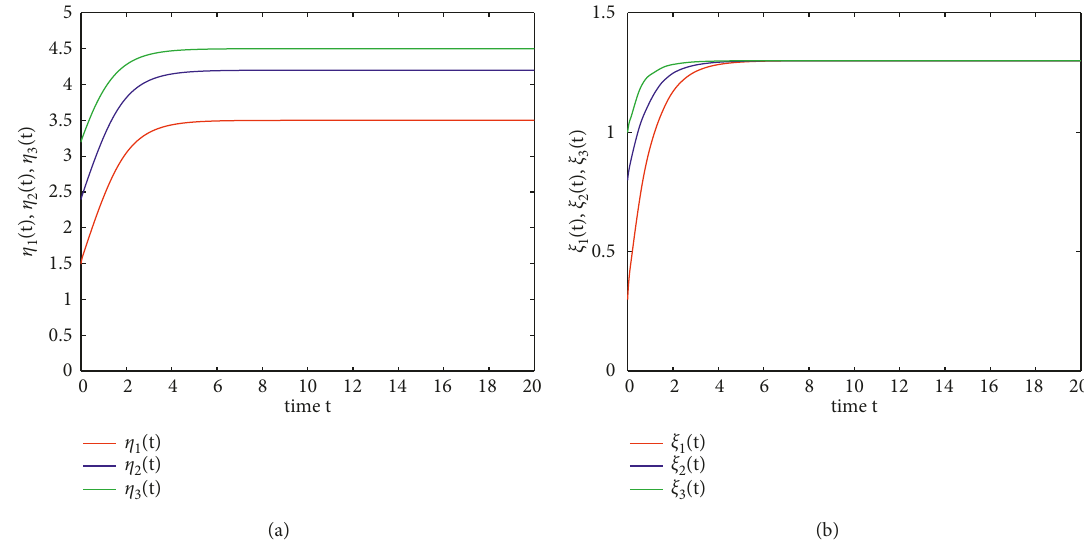
( t ) , η ( t ) , and η ( t ) with the adaptive controller (58); (b) trajectories of control pa- 1 2 3